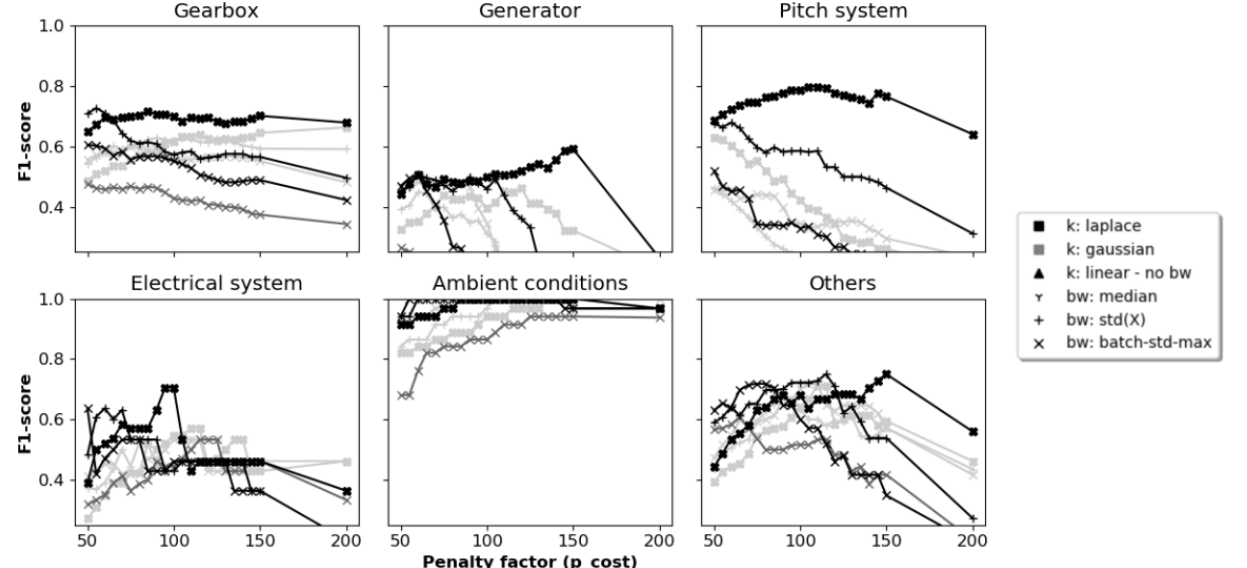
Figure C3. The 2-year signal selection: F1 scores per component for different hyperparameter configurations and penalty values.